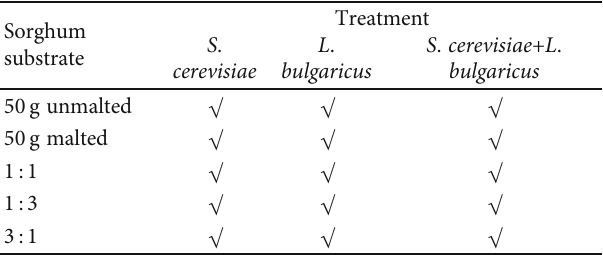
Figure 1: Unmalted (a) and malted (b) sorghum grains before milling for use in Table 1: Sorghum substrates and treatments employed in their fermentation.